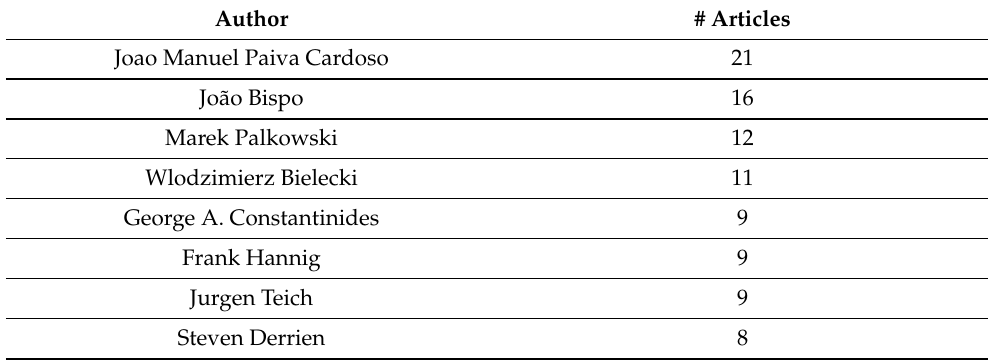
Table 11. Top 10 most-recurrent authors (any